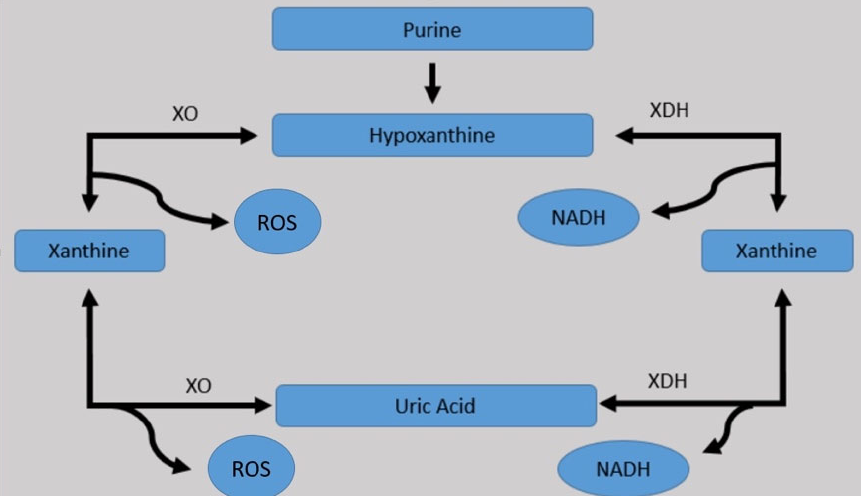
Figure 1. Metabolism of purine through xanthine oxidoreductases. XO, xanthine oxidase; XDH, xanthine dehydrogenase; ROS, reactive oxygen species; NADH, nicotinamide adenine dinucleotide (Modified after: [23]).